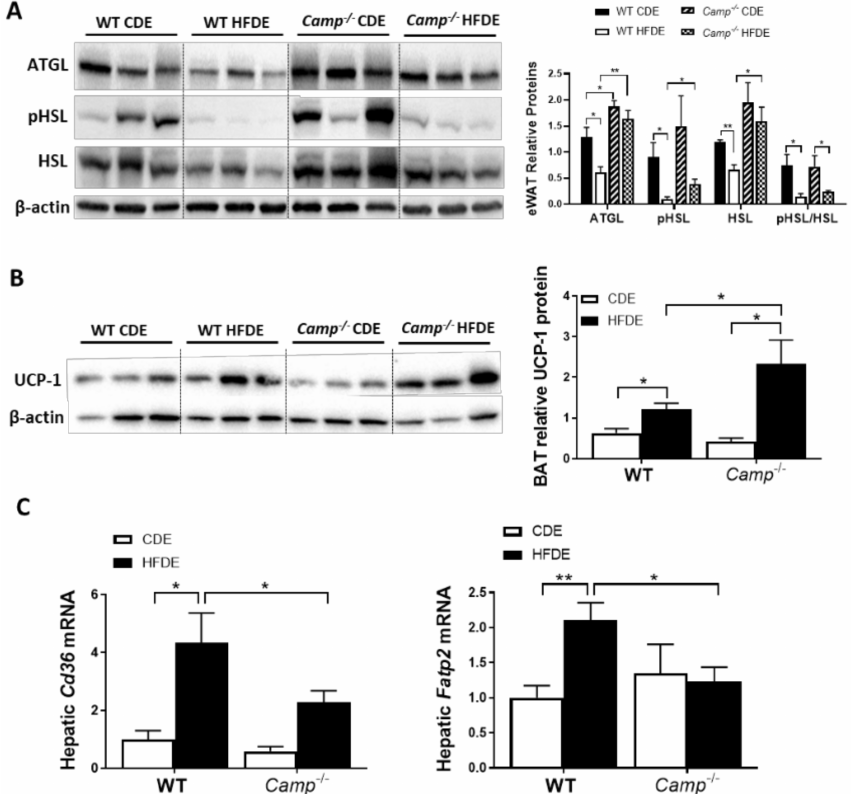
Figure 5. The effects of Camp deletion on adipose lipolysis, UCP1 protein expression in brown adipose tissue, and hepatic lipid transporter gene expression in mice fed with HFDE. ( A ) Representative immunoblots (left panel) and quantification (right panel) of lipolytic enzymes ATGL and HSL in eWAT. ( B ) Representative immunoblots (left panel) and quantification (right panel) of BAT UCP1 protein. ( C ) Hepatic mRNA expression of Cd36 and Fatp2 . Data are expressed in Mean ± SEM (n = 5 mice/group). * p ≤ 0.05, ** p ≤